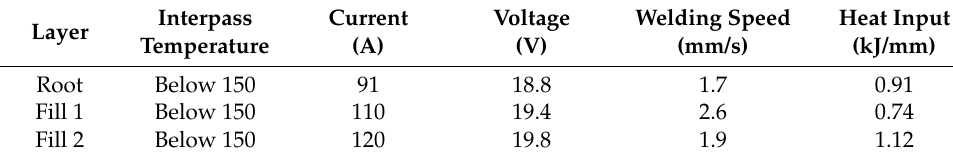
Table 5. Welding parameters for joints with